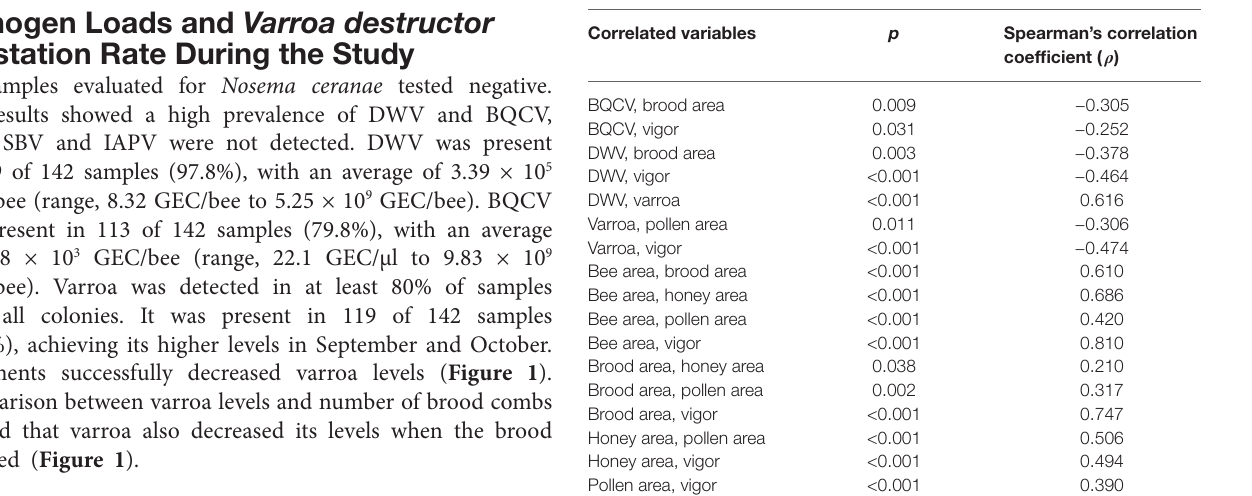
TABLE 1 | Significant correlations among variables in the